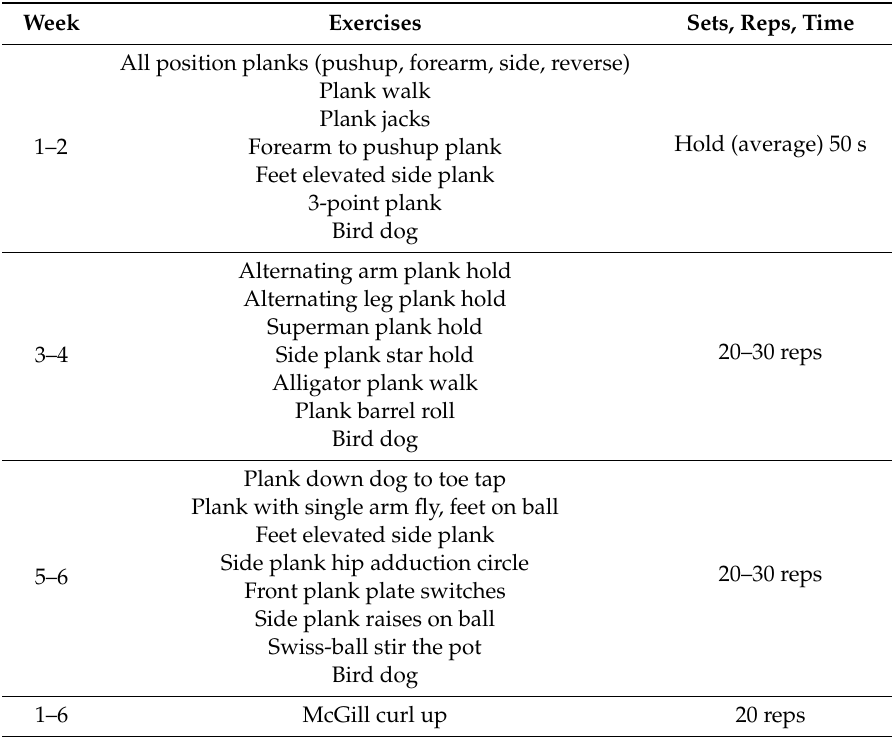
Table 1. Core strengthening